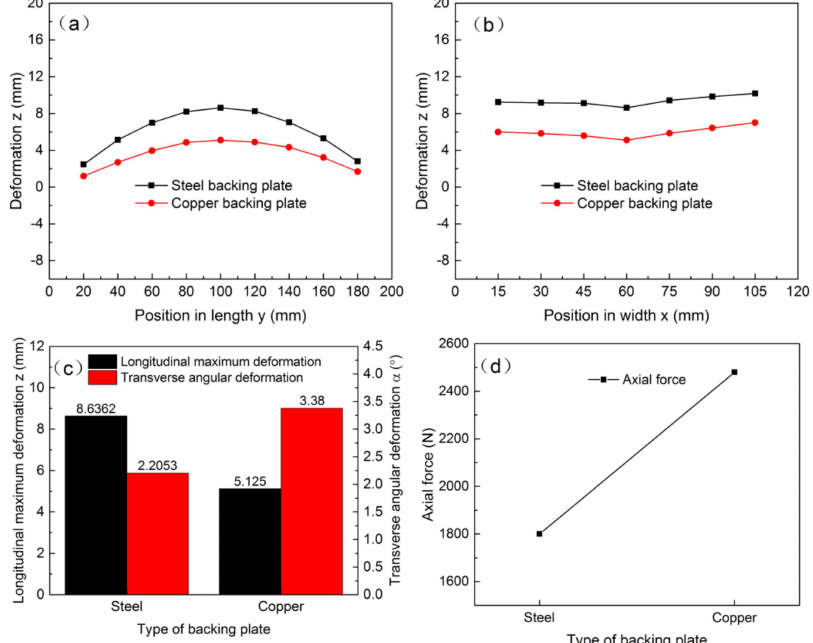
Figure 12. Deformation comparison for di ff erent backing plates: ( a ) in longitudinal direction at position x = 0, ( b ) in transverse direction at position y = 100 mm, ( c ) longitudinal maximum bending deformation and transverse angular deformation, and ( d ) axial